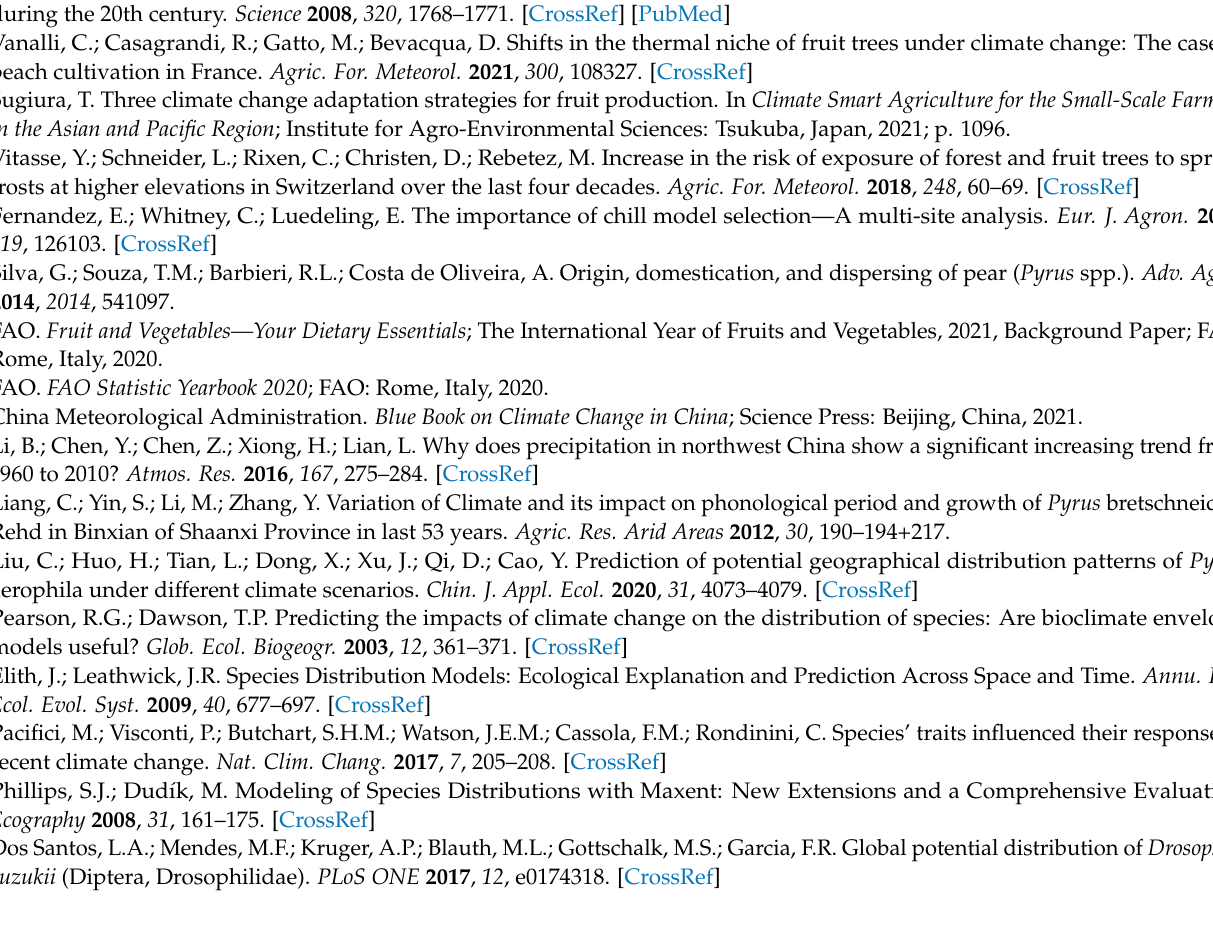
Figure S2: Distribution map of climatically suitable areas of P. pashia under future climatic conditions. Figure S3: Distribution map of climatically suitable areas of P. ussuriensis under future climatic conditions. Figure S4: Distribution map of climatically suitable areas of P. pyrifolia under future climatic conditions. Figure S5: Distribution map of climatically suitable areas of P. sinkiangensis under future climatic